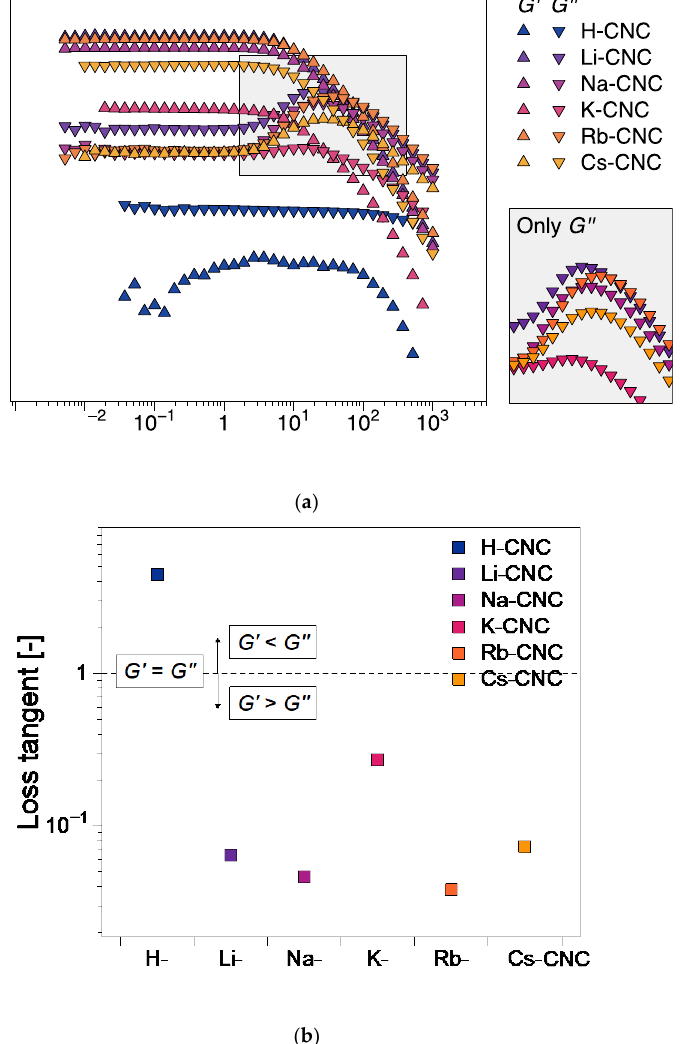
Figure 4. Oscillatory shear strain sweep tests for CNC suspensions presenting the ( a ) dynamic moduli profile against the shear strain amplitude and ( b ) loss tangent (tan = G ″ / G ′ ) from the viscoelastic data in ( a ) as function of the type of counter cation. The oscillatory shear strain sweep tests were conducted at a fixed angular frequency of ω = 6.28 rad⁄s.